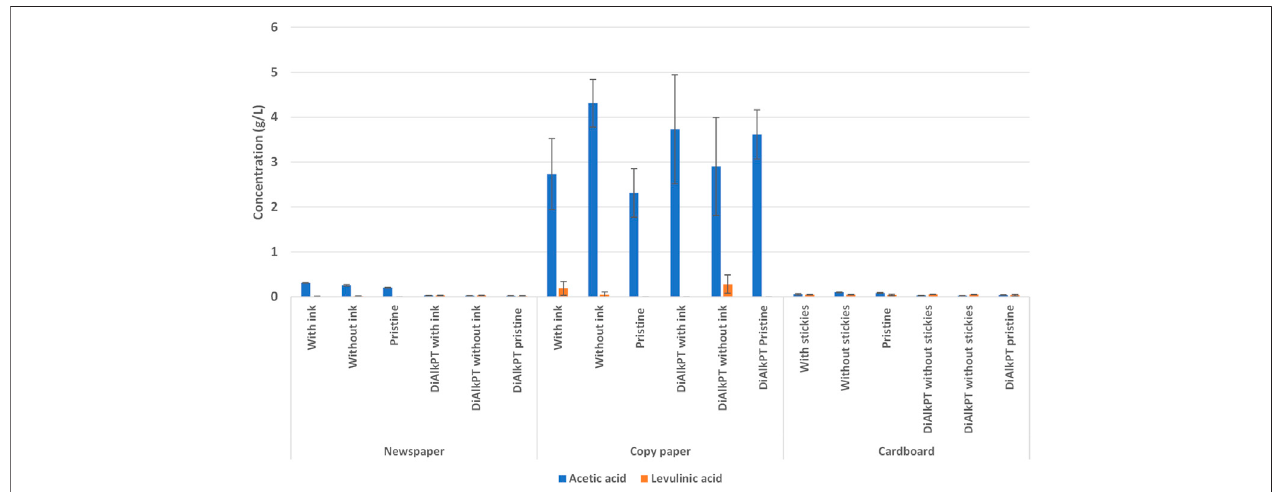
FIGURE 8 | Copy paper had an elevated concentration of the fermentation inhibitor acetic acid during enzymatic hydrolysis. DiAlkPT, dilute alkaline pre-treated.